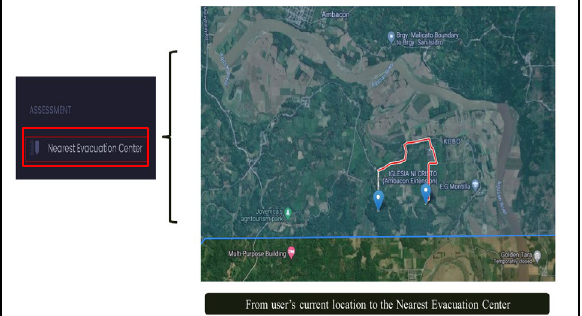
Figure 13. Finding the Nearest Available Evacuation Center from the User’s